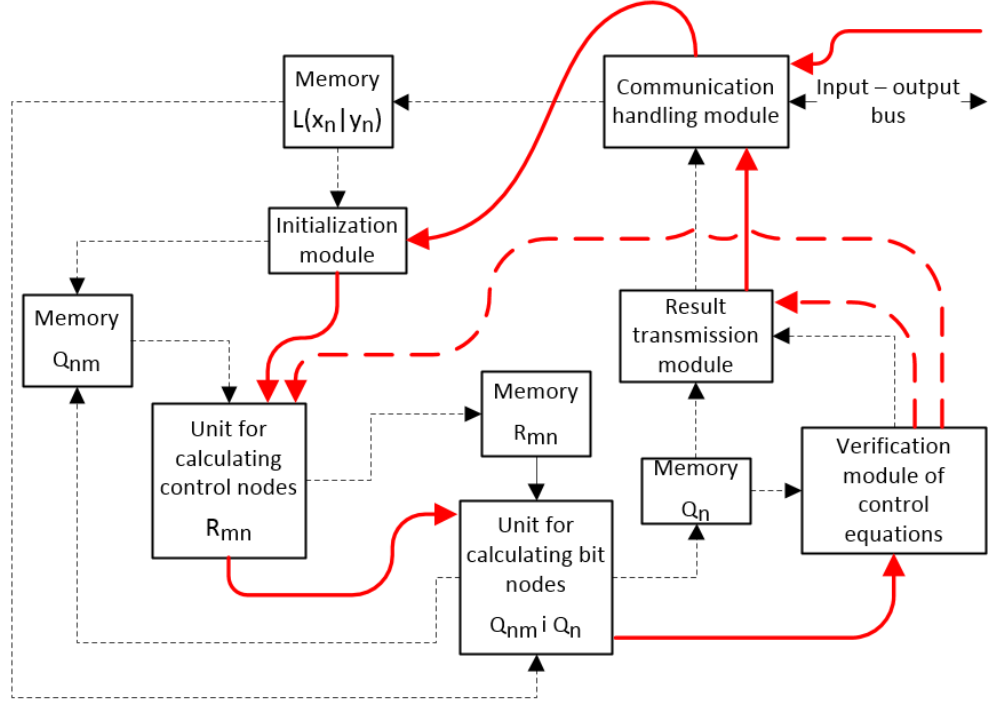
Figure 4. Handing over the Token in a distributed control